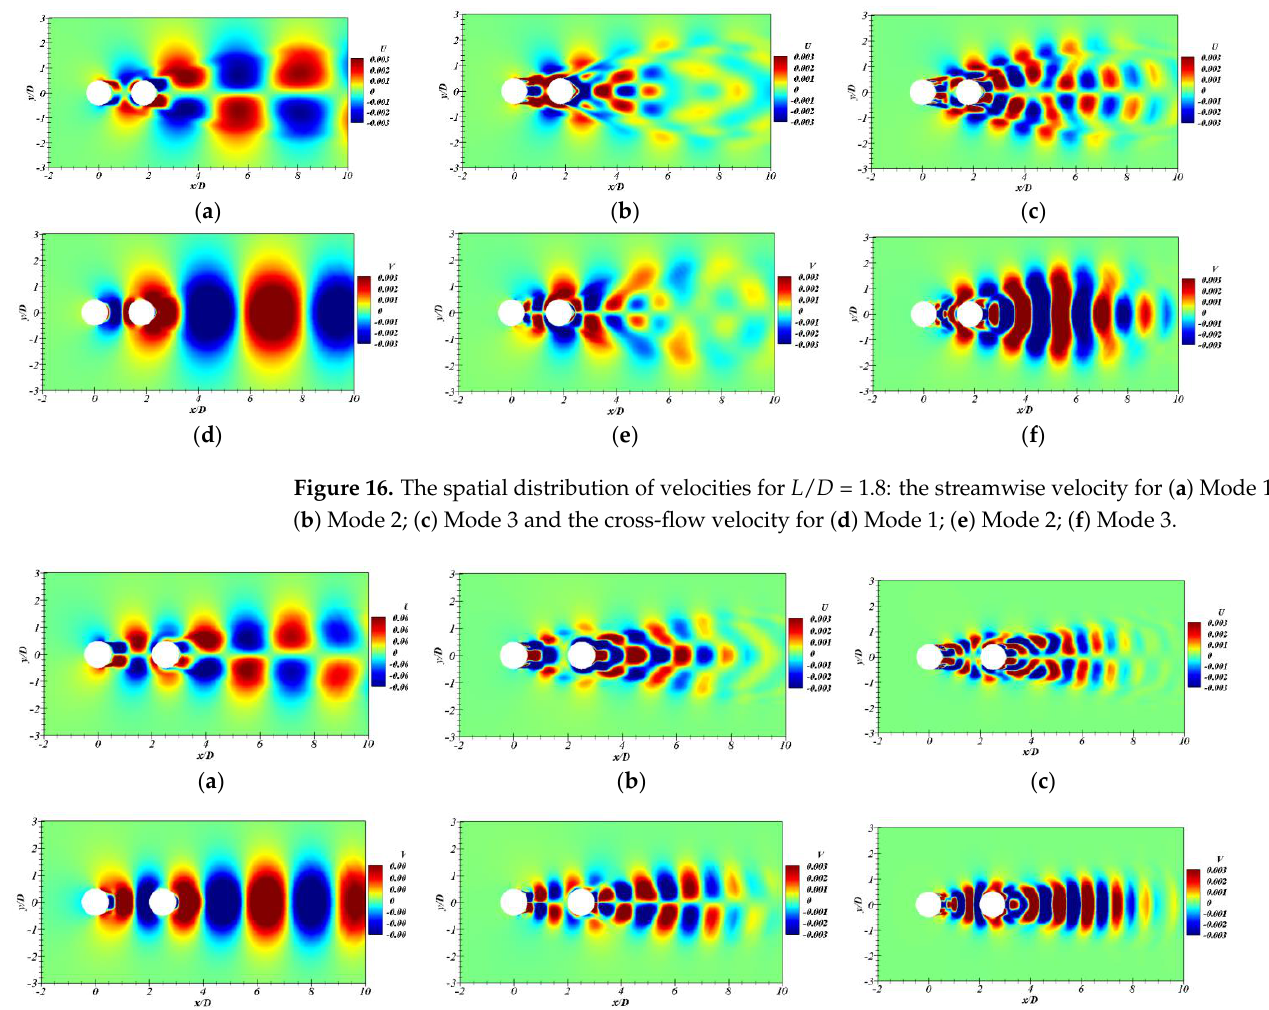
Modes 1 and 3 revealed a top – bottom mirrored symmetry with respect to the centreline